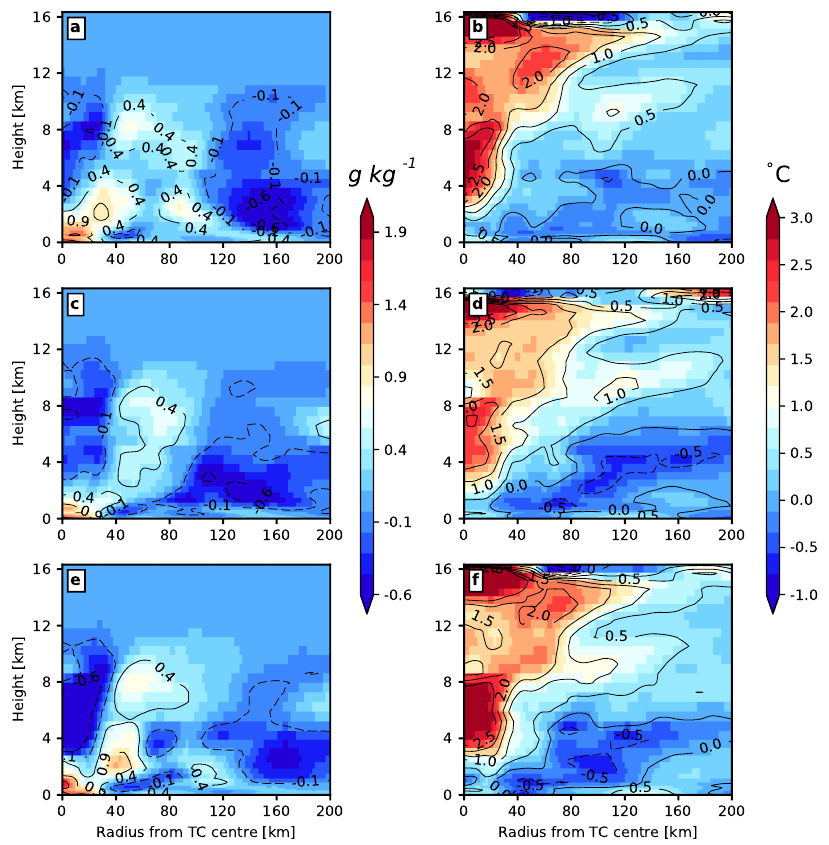
Figure 16. Height–radius cross sections of the difference of the azimuthally averaged mixing ratio (left) and temperature (right), for ( a, b ) Expt. 2, ( c, d ) Expt. 3, and ( e, f ) Expt. 4. The difference was calculated by subtracting the azimuthal averaged quantity for Expt. 1 from the respective coupled model results at 00:00UTC on 3 July